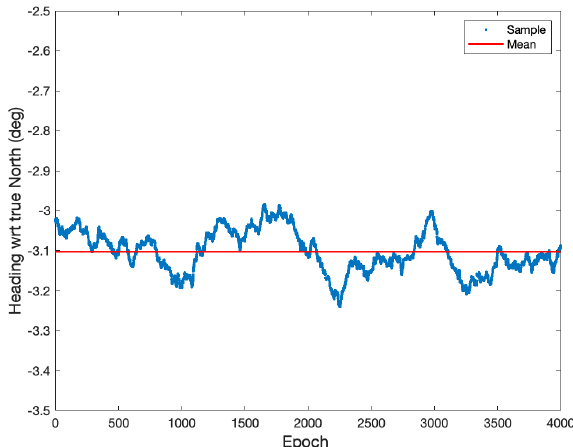
Figure 11. Heading measurements of the baseline shown in Figure 10. The measurements were obtained from a ST Micro LSM3030D magnetometer at a rate of 10 Hz. The mean value of the measurement data was –3.1 °, and the standard deviation was 0.05 °